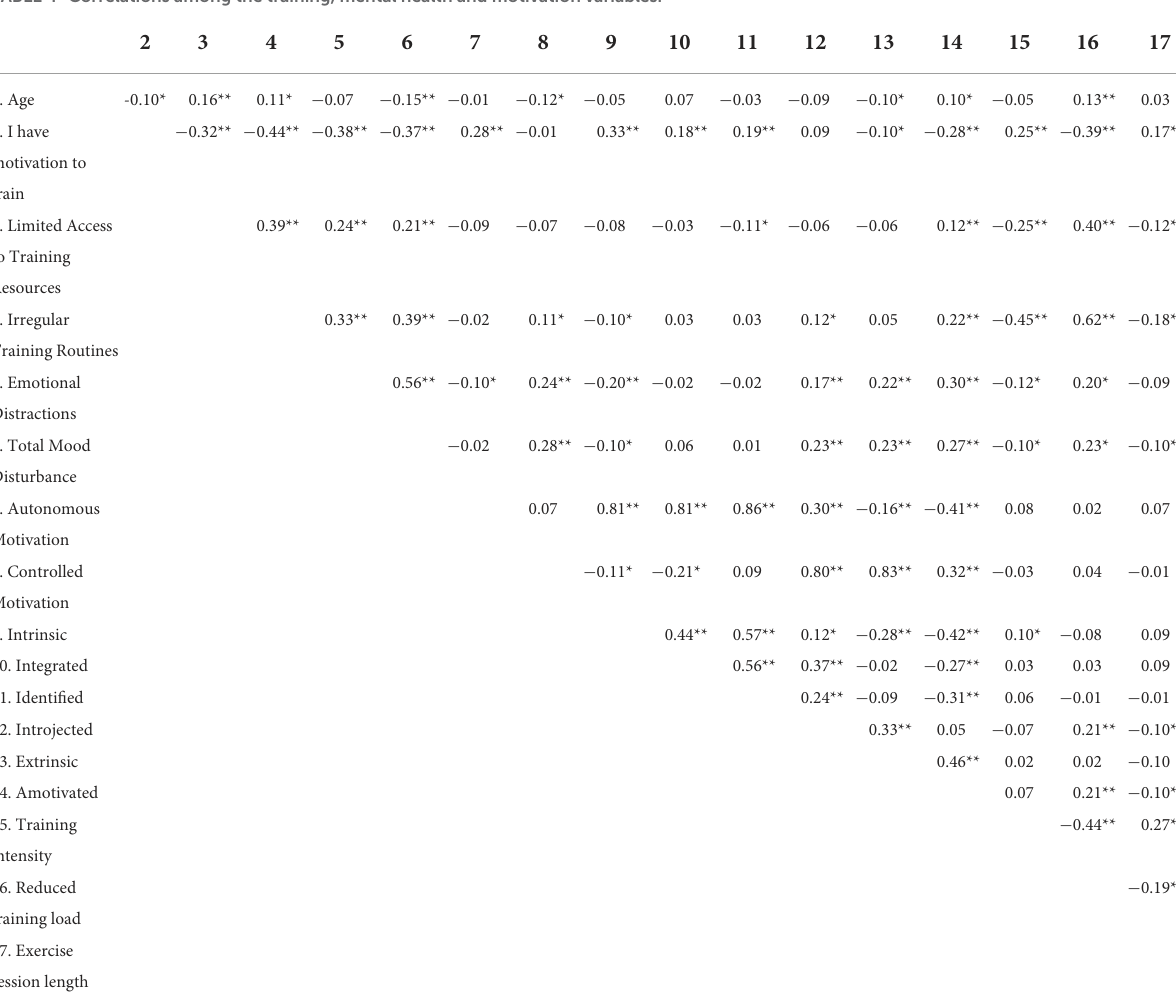
TABLE 4 Correlations among the training, mental health and motivation